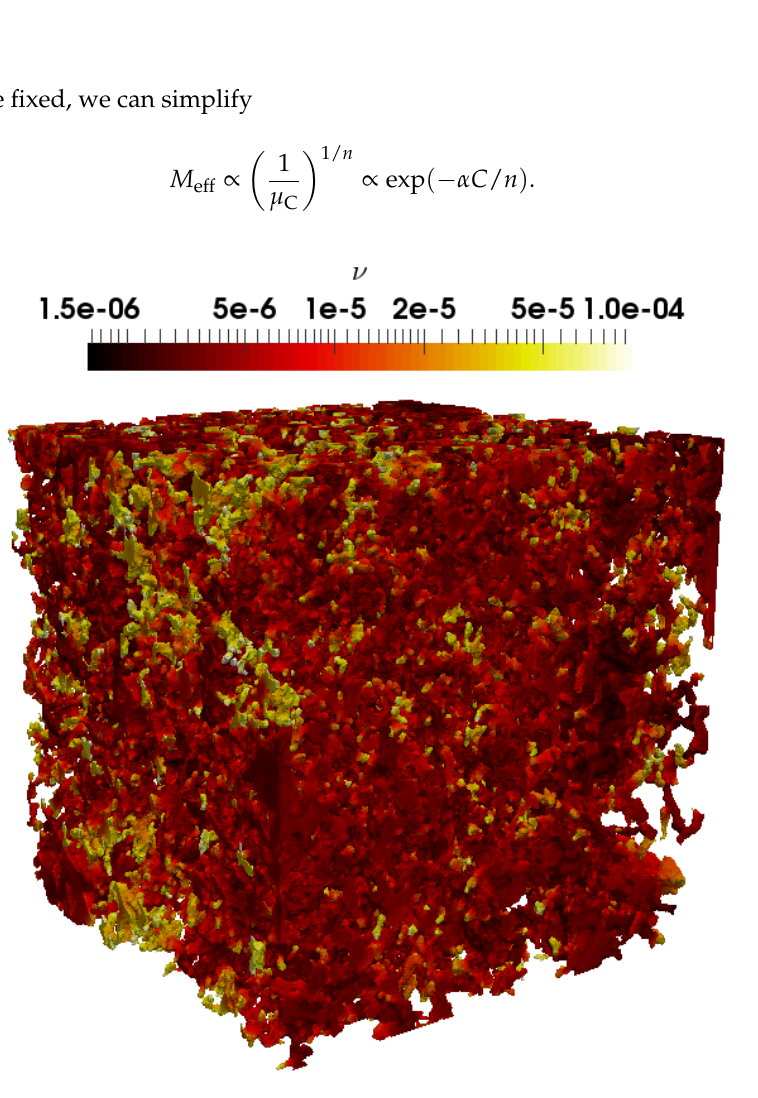
Figure 7. Simulated kinematic viscosity field ν (m 2 s − 1 ) for the carbonate, displaying in logarithmic field for